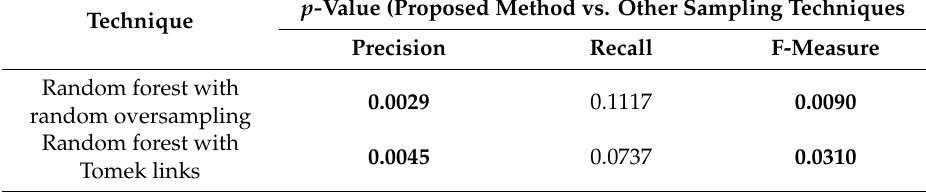
Table 10. Significance of precision, recall, and F-measure results using the proposed method and other sampling